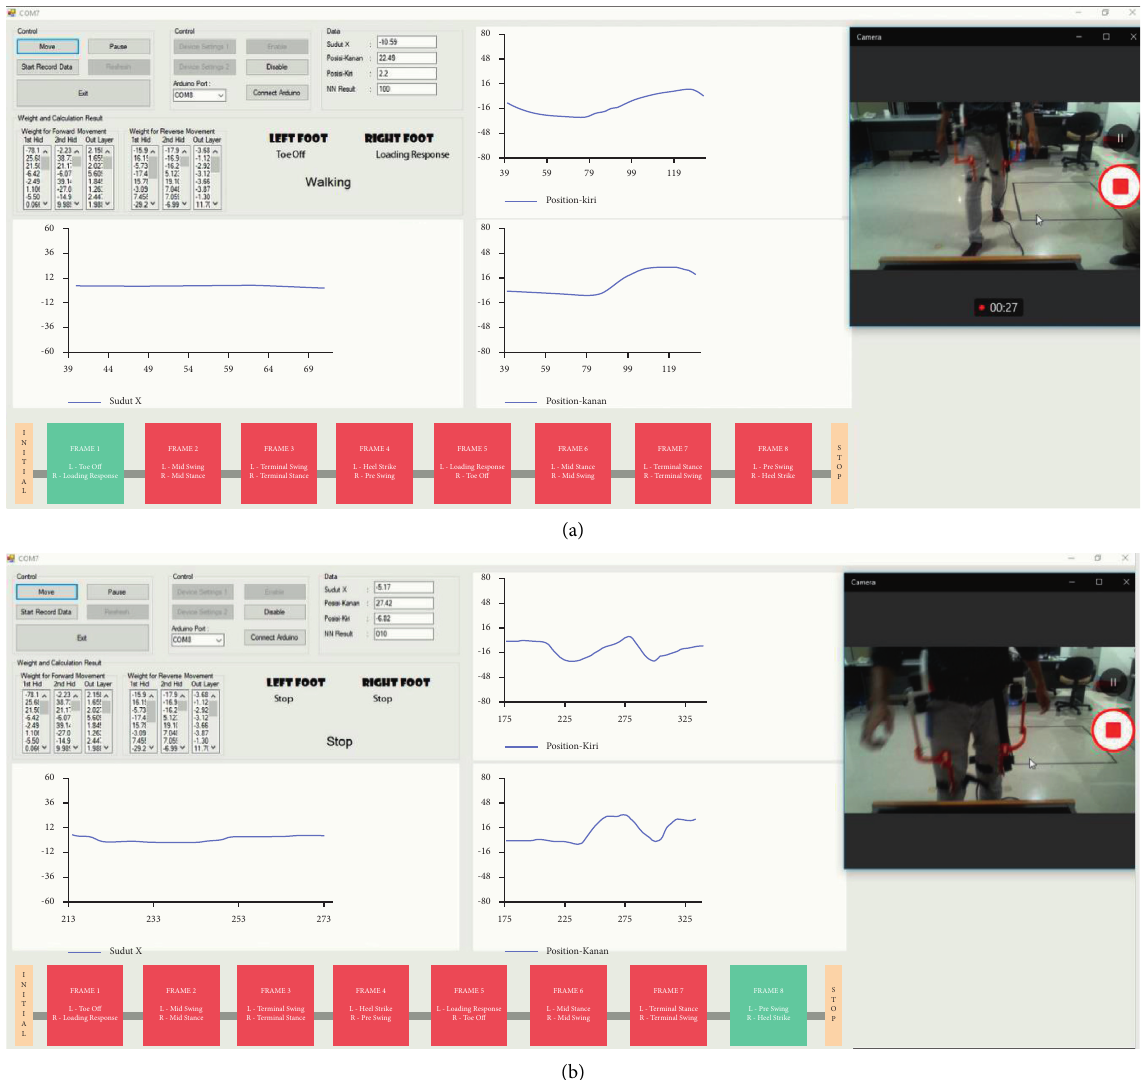
Figure 8: Detection of walking intention. (a) When the user is walking and (b) when the user has